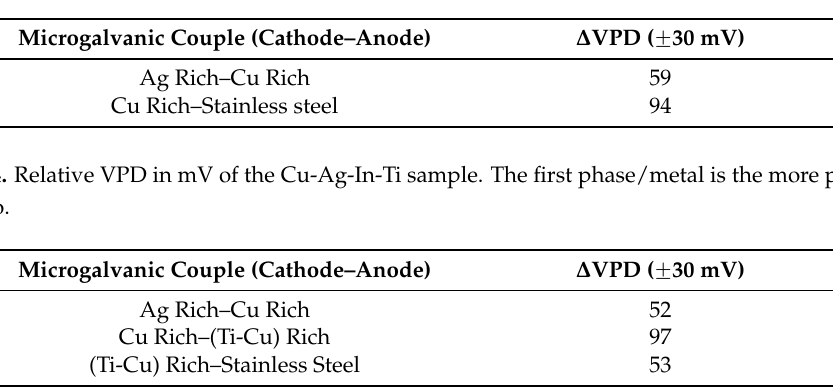
joint. The first phase/metal is the more positive of the two.